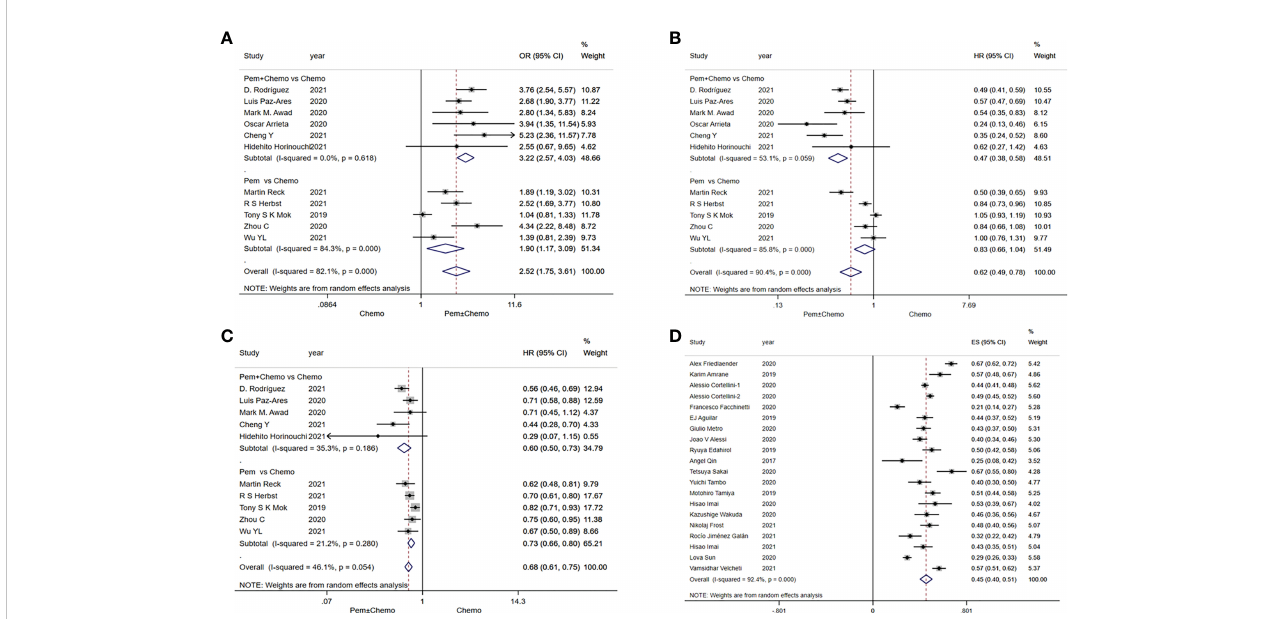
FIGURE 2 Forest plots of survival outcomes in randomized clinical trials (RCTs) and real-world studies (RWSs). (A) objective response rate in RCTs, (B) progression- free survival in RCTs, (C) overall survival in RCTs, (D) objective response rate in